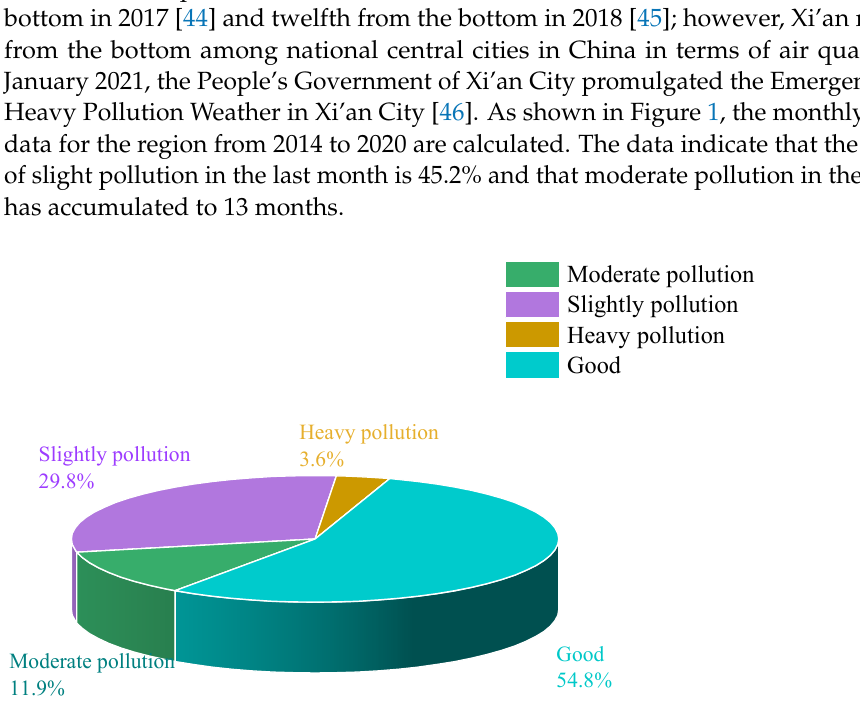
Figure 1. Distribution of air quality in Xi’an from 2014 to 2020.